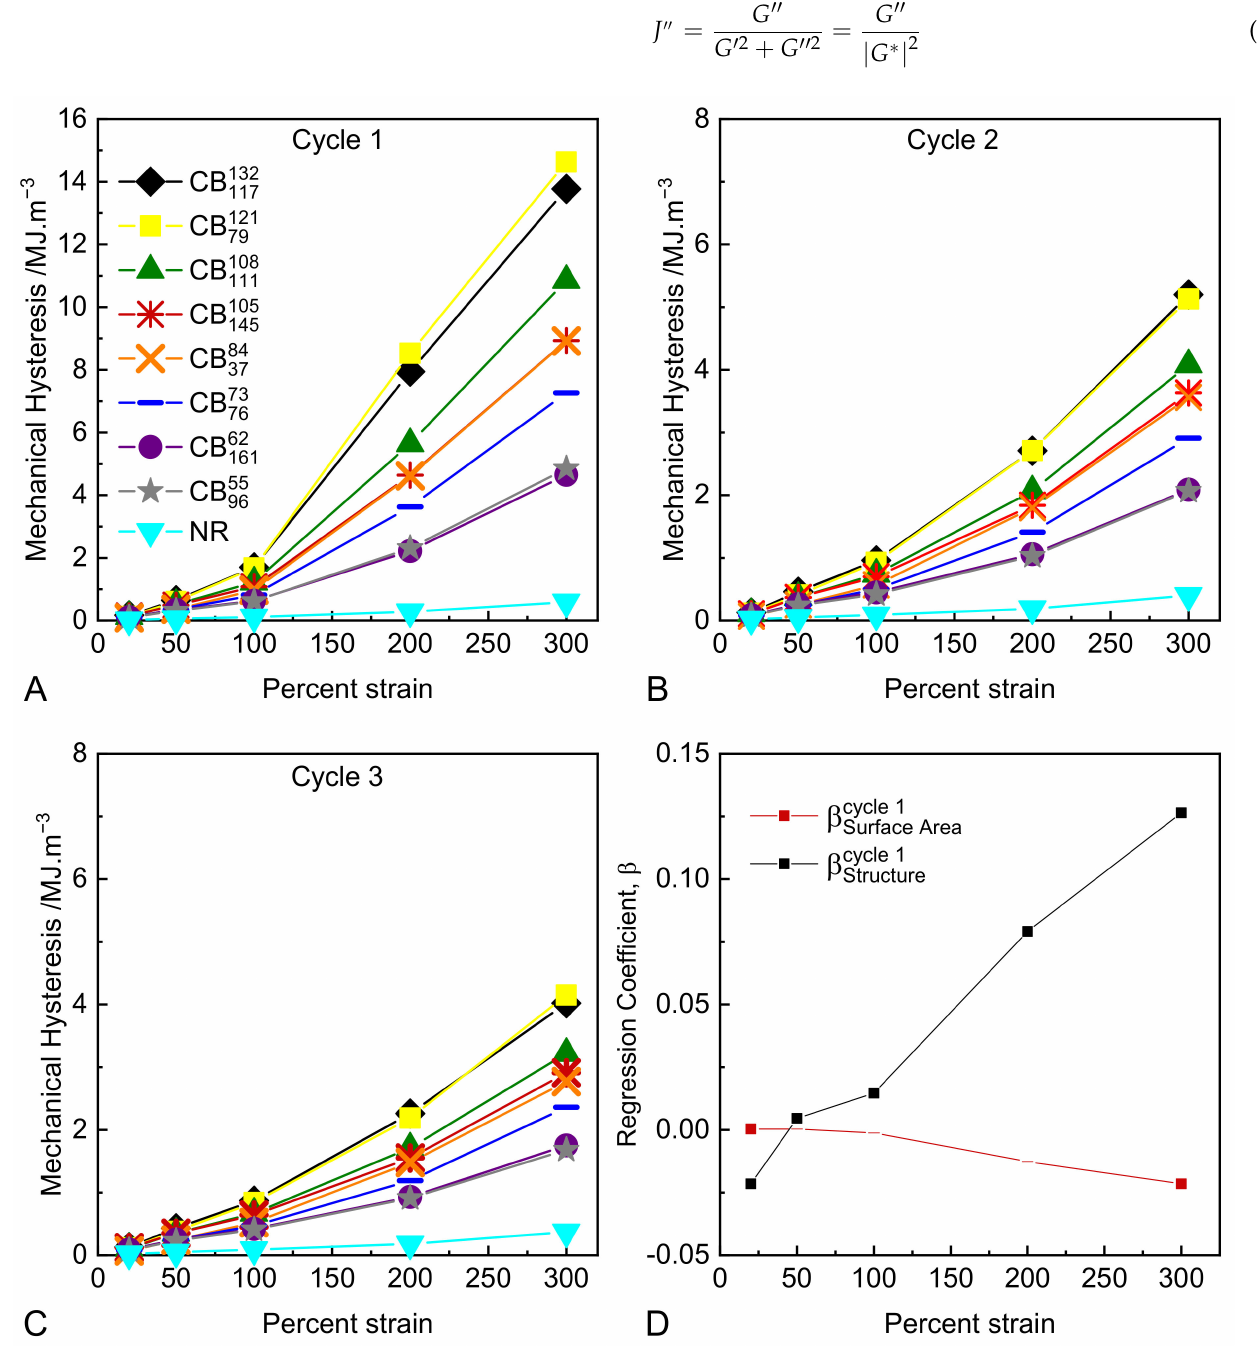
Figure 4. ( A – C ) Mechanical hysteresis after the first, second and third, strain cycles respectively (note the difference in ordinate scale between the first, second, and third cycle data); ( D ) regression coefficients of structure and surface area compared to mechanical hysteresis as measured on the first strain cycle (data points with p values > 0.05 are